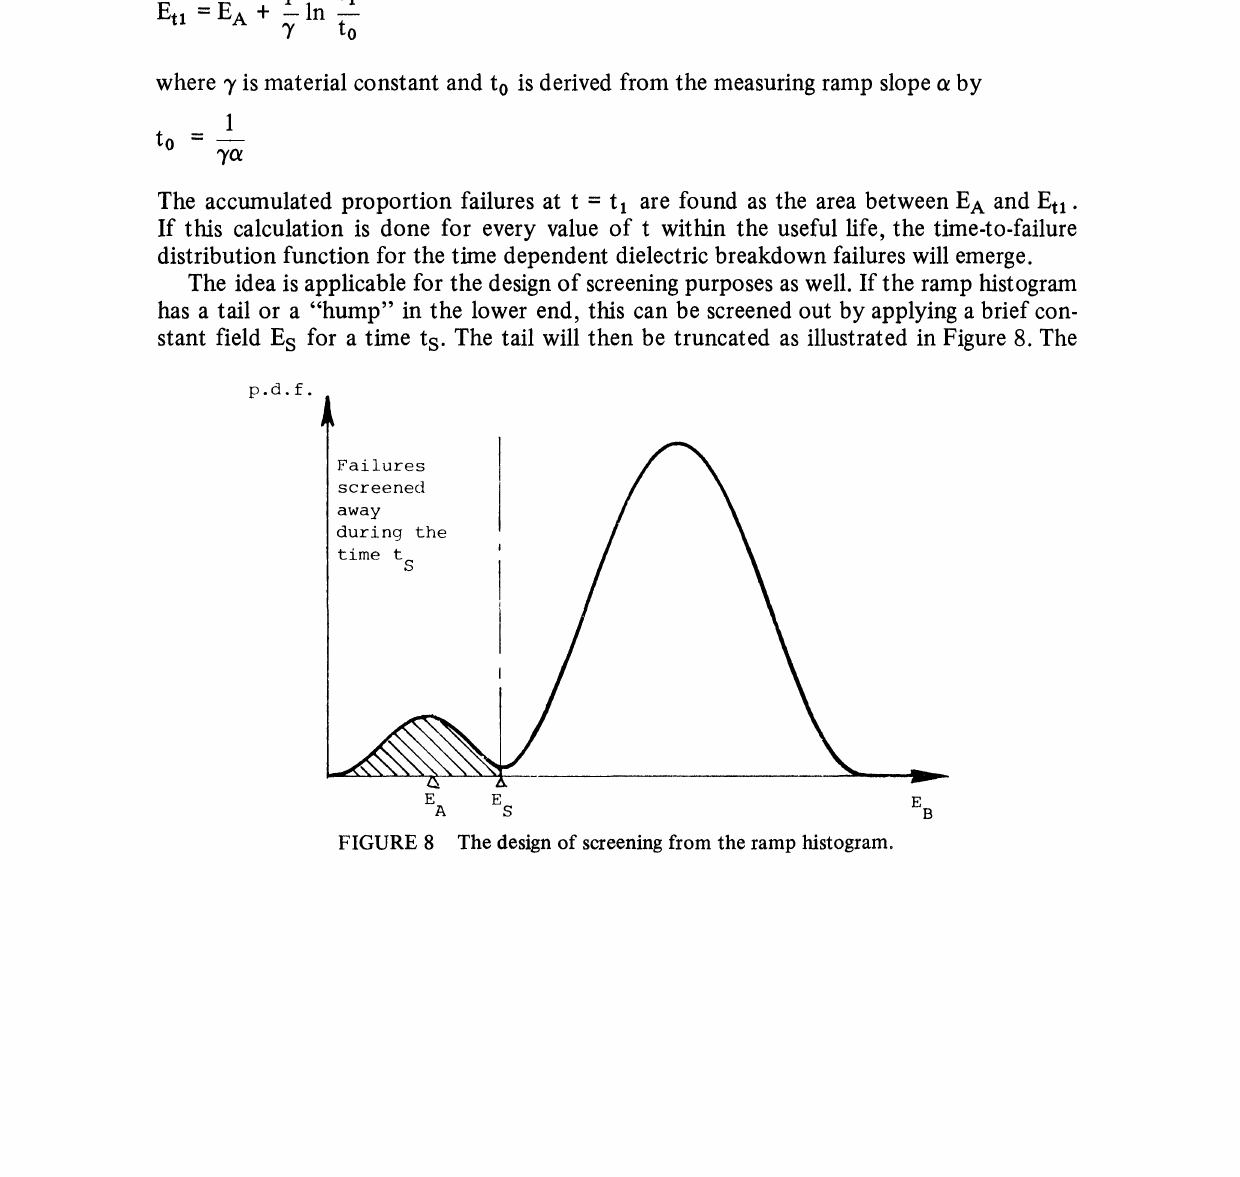
FIGURE 7 The ramp histogram (from ref. 10).